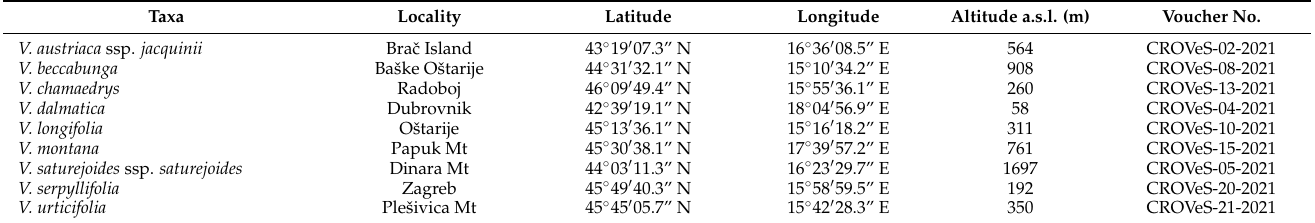
Table 1. Details on collection data and origin of investigated Veronica